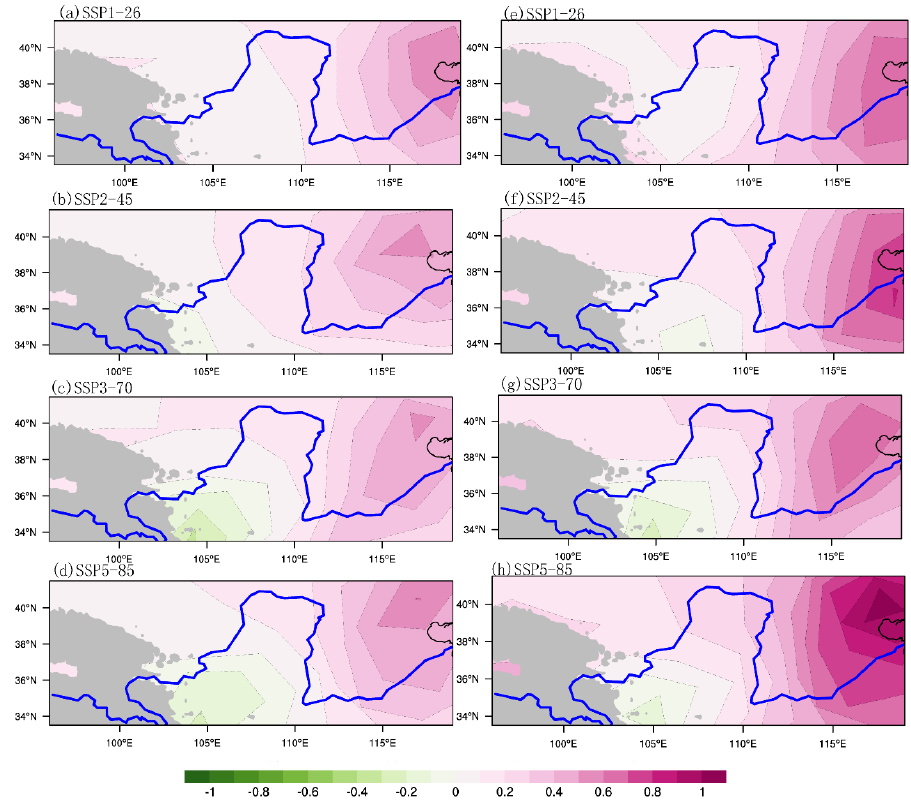
Figure 3. Future changes of summer precipitation (shaded; units: mm d − 1 ) projected by the MMM of the selected CMIP6 models under ( a ) SSP1-2.6; ( b ) SSP2-4.5; ( c ) SSP3-7.0; and ( d ) SSP5-8.5 during the former half period of the 21st century, and under ( e ) SSP1-2.6; ( f ) SSP2-4.5; ( g ) SSP3-7.0; and ( h ) SSP5-8.5 during the latter half period of the 21st century, relative to the historical mean. The blue line indicates the Yellow River. Grey shading denotes the TP.